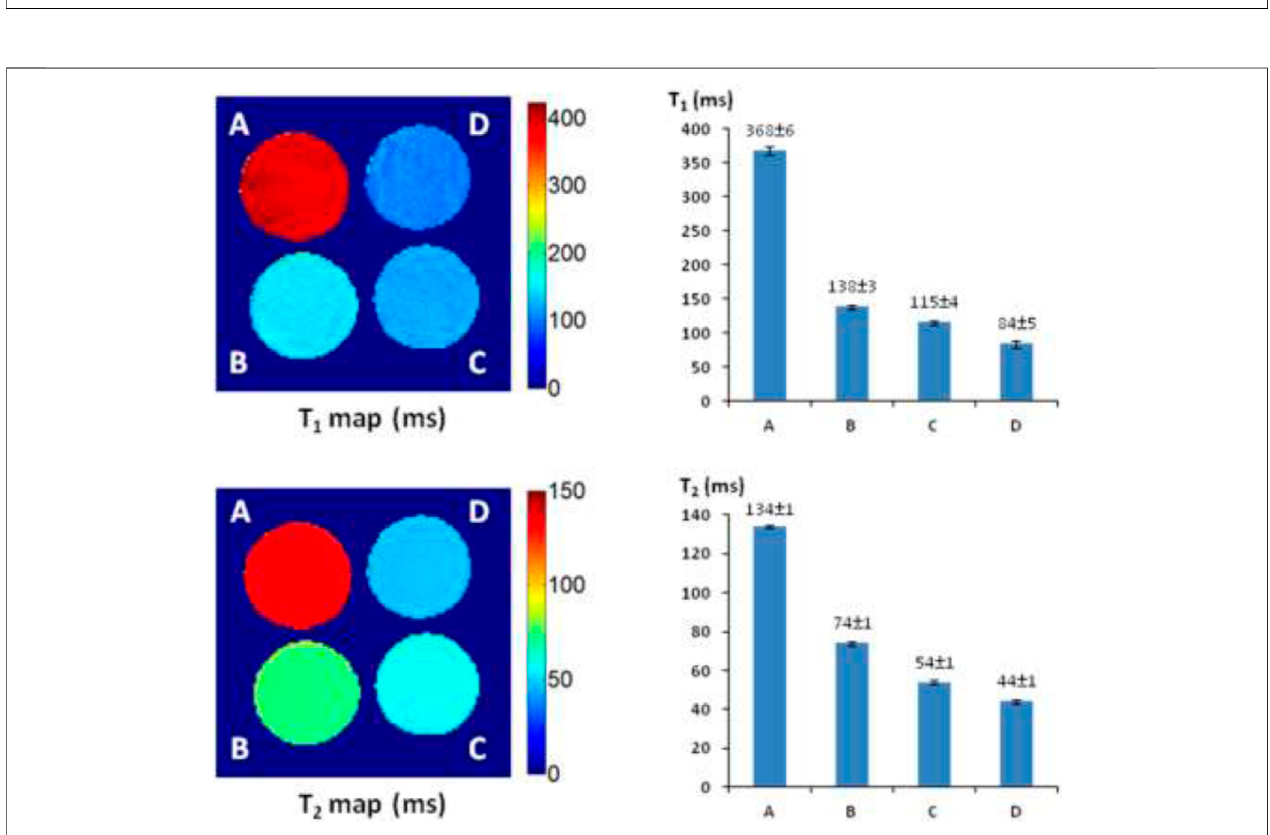
FIGURE 5 | 1 H-MRI detection of β -gal activity. 1 H-MRI acquisition: using the same parameters as in Figure 2 , (A) alizarin 2- O - β - D -galactopyranoside AZ-1 (9.0 mM) and FAC (15.0 mM); (B) alizarin 2- O - β - D -galactopyranoside AZ-1 (4.0 mM), FAC (15.0 mM), and β -gal (E801A, 5 units); (C) alizarin 2- O - β - D -galactopyranoside AZ-1 (6.0 mM), FAC (15.0 mM), and β -gal (E801A, 5 units); (D) alizarin 2- O - β - D -galactopyranoside AZ-1 (9.0 mM), FAC (15.0 mM), and β -gal (E801A, 5 units) in 1:1 (V/V ′ ) DMSO/PBS (0.1 M, pH (cid:1) 7.4) at 37 ° C in 4 h.